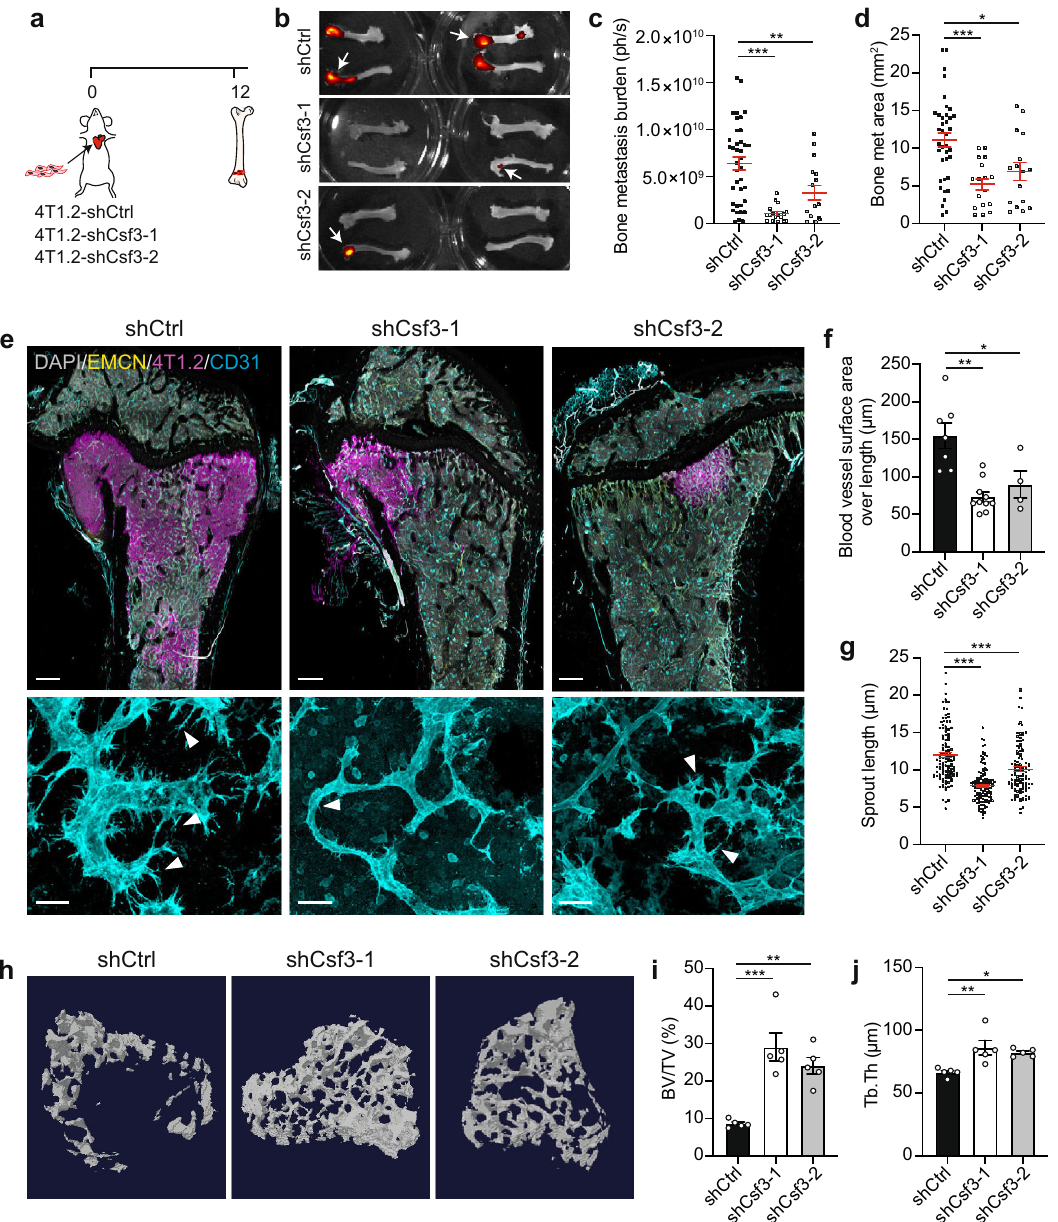
Fig. 7 G-CSF de fi ciency suppresses remodelling of the BM vascular niche and bone metastasis. a Strategy to test the bone metastatic ability of G-CSF- de fi cient 4T1.2 cells. b Ex vivo fl uorescence imaging of bones collected at experimental endpoint. Arrows point to metastasis in bone. c , d Quanti fi cation of photon fl ux ( c ) and bone metastasis area ( d ) from ( b ). Individual dots are from one bone. n = 11 (shCtrl) and 8 mice (shCsf3-1, shCsf3-2). In ( c ), ** P = 0.0080, *** P < 0.0001. In ( d ), * P = 0.0126, *** P = 0.0003. P values, one-way ANOVA and Dunnett ’ s multiple comparisons test. e Representative 3D images (top) and enlarged micrographs (bottom) of femoral BM from mice injected with 4T1.2-shCtrl, 4T1.2-shCsf3-1 or 4T1.2-shCsf3-2 cells. Bones were stained for DAPI (grey), 4T1.2 cells (magenta), EMCN (yellow) and CD31 (cyan) ( n = 5 mice per cell line). Arrowheads indicate endothelial sprouts. Scale bars: 300 µ m (overviews), 10 µ m (enlargements). f , g Quanti fi cation of surface area over length ( f ) and sprout length ( g ) of blood vessels from ( e ). Individual dots are from one vessel ( f ) or sprout ( g ). n = 3 mice per group. * P = 0.0116, ** P = 0.0002, *** P < 0.0001 by one-way ANOVA and Dunnett ’ s multiple comparisons test. h – j Representative micro-computed tomography images ( h ) and morphometric analysis of tibial trabecula from metastasis- bearing mice. Data are presented as percentage of bone volume/tissue volume (BV/TV; %) ( i ) and trabecular thickness (Tb.Th; µ m) ( j ). n = 5 mice per group. In ( i ), ** P = 0.0016, *** P = 0.0002. In ( j ), * P = 0.0168, ** P = 0.004. P values, one-way ANOVA and Dunnett ’ s multiple comparisons test. All data re fl ect mean ± s.e.m. Source data are provided as a Source Data fi metastatic breast cancer 39 , in the spontaneous metastasis model anti-G-CSFR monotherapy had limited ef fi cacy in the early phase (Supplementary Fig. 6j). As expected, docetaxel alone markedly of tumorigenesis. However, subsequent disease progression was inhibited tumour growth at early time points but resistance to attenuated (potentially by suppressing tumour angiogenesis 40 ), chemotherapy eventually emerged, resulting in widespread and achieved comparable survival to cohorts treated with metastases (Supplementary Fig. 6k, m). As observed above, docetaxel (Supplementary Fig. 6l). Furthermore, the neutralising